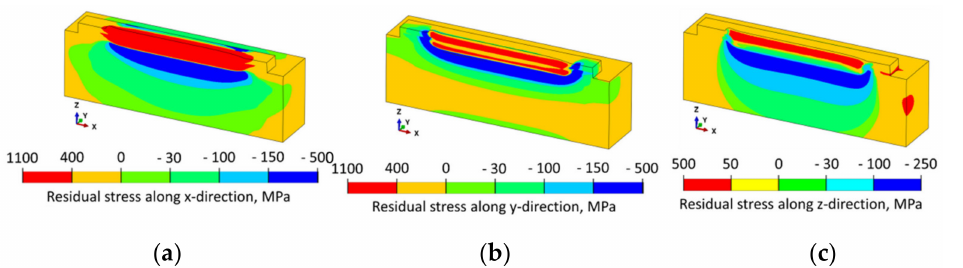
Figure 5. Comparison of the melt pool in ( a ) DED and ( b ) SLM to learn about the thermal history and cooling rate [41].